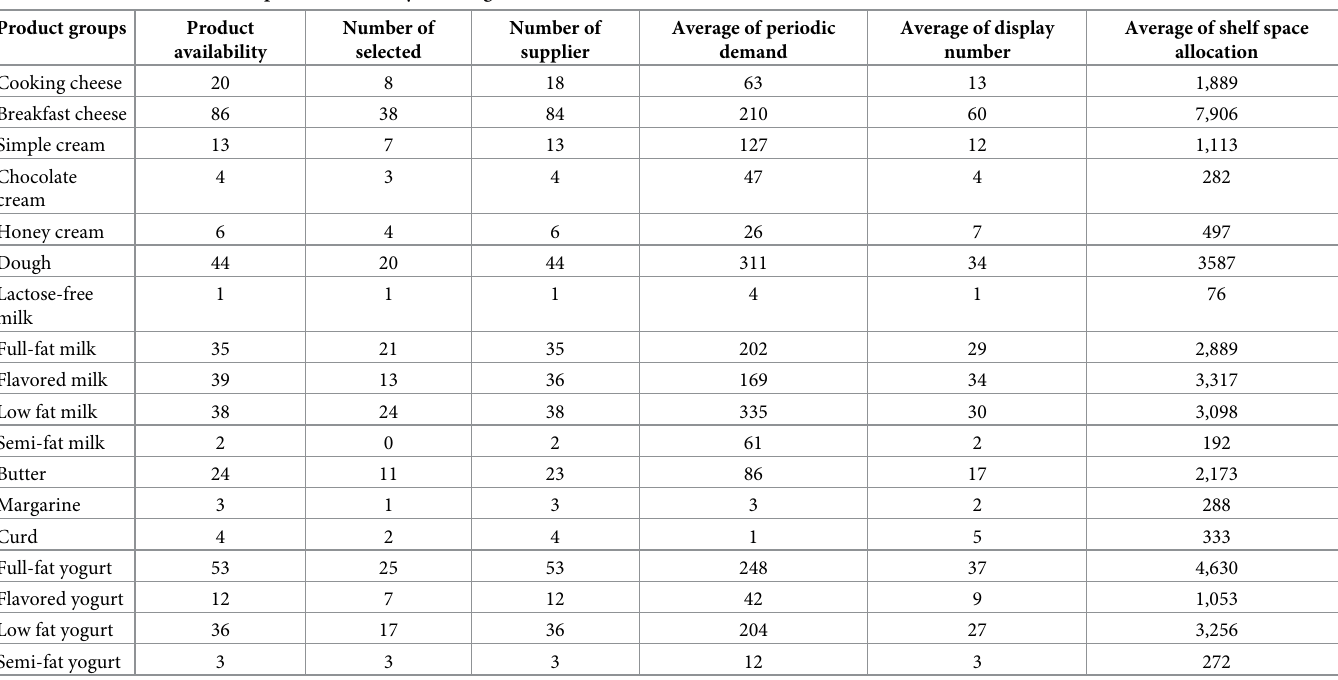
Table 13. The results of the real problem solved by VDO algorithm. Product